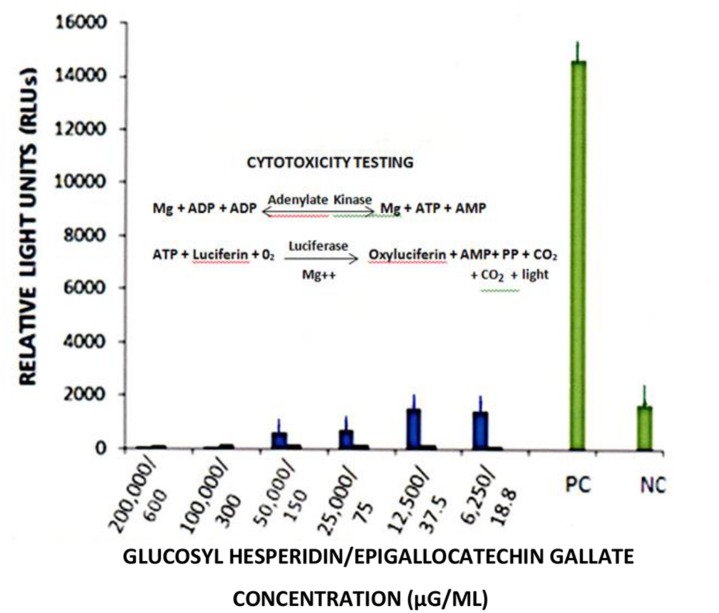
Cytotoxicity testing of glucosyl hesperidin and epigallogatechin gallate MA-104 cell cultures. Cytotoxicity testing employed the “ToxilightR Non-Destructive Cytotoxicity Assay”. Readings were performed using a Modulus luminometer (Turner Biosystems/Promega Corp., Sunnyvale, CA, USA) with data presented as relative light units (RLUs). Data points represent the mean ± SE of the means. P < 0.05 were assumed statistically significant.